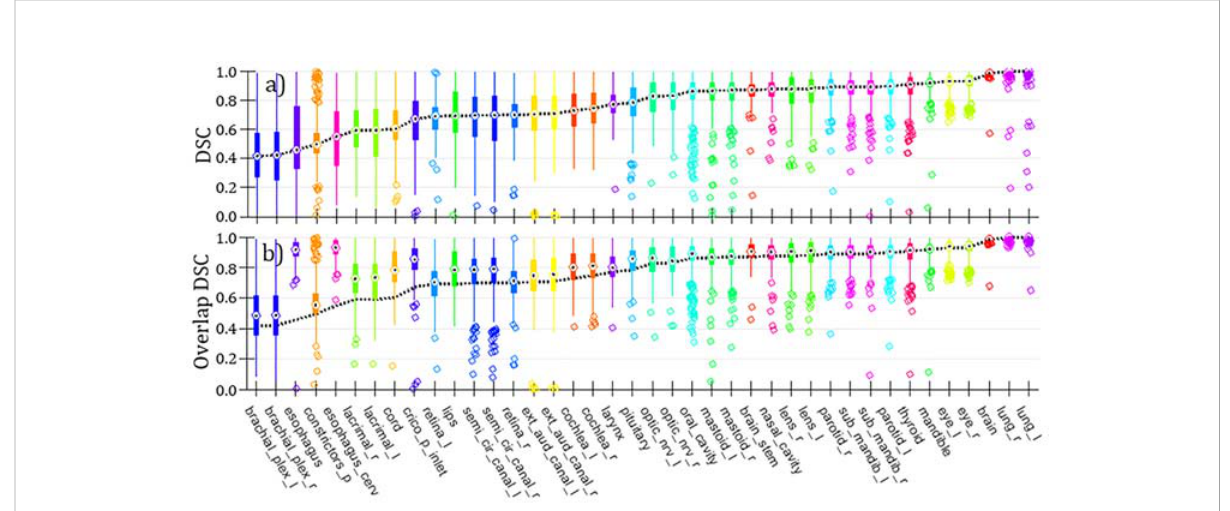
FIGURE 4 (A) Box and whisker plots of DSC comparing curated versus clinical H&N OARs (N Cases =490; counts per OAR are variable, dependent on set of OARs available per case). “ Bulls-eyes ” indicate the median values; medians are connected over all OARs with a dashed line. (B) Same representation as in panel (A) for alternative metric Overlap DSC. The dashed line showing medians from (standard) DSC (taken from panel) (A) is projected onto this panel for comparison.